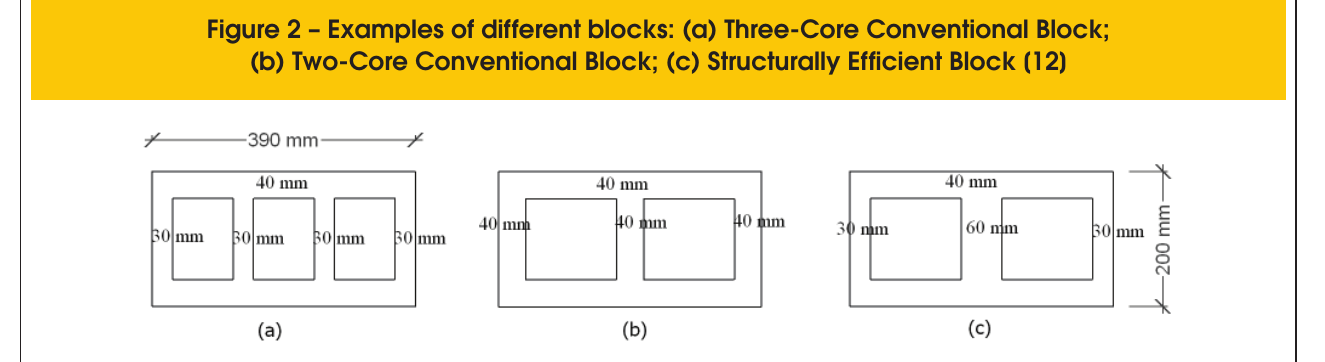
Figure 2 – Examples of different blocks: (a) Three-Core Conventional Block; (b) Two-Core Conventional Block; (c) Structurally Efficient Block